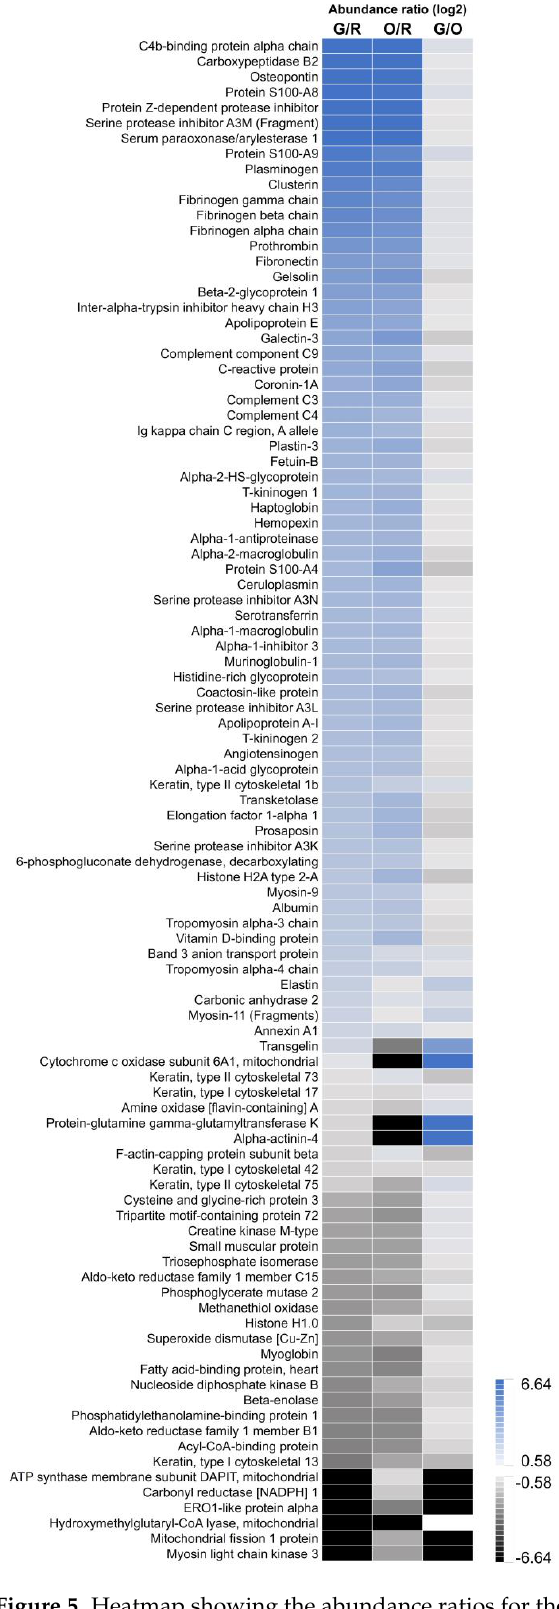
Figure 5. Heatmap showing the abundance ratios for the differential proteins (n = 99). In blue the upregulated proteins (log2 ratio ≥ 0.58), the downregulated proteins (log2 ratio ≤ − 0.58) in black. R = Red; Unaffected tissue, O = Orange; Infarct border, G = Green; Infarct core. G/R is the ratio of Green versus Red, O/R is the ratio of Orange versus Red, G/O is the ratio of Green versus